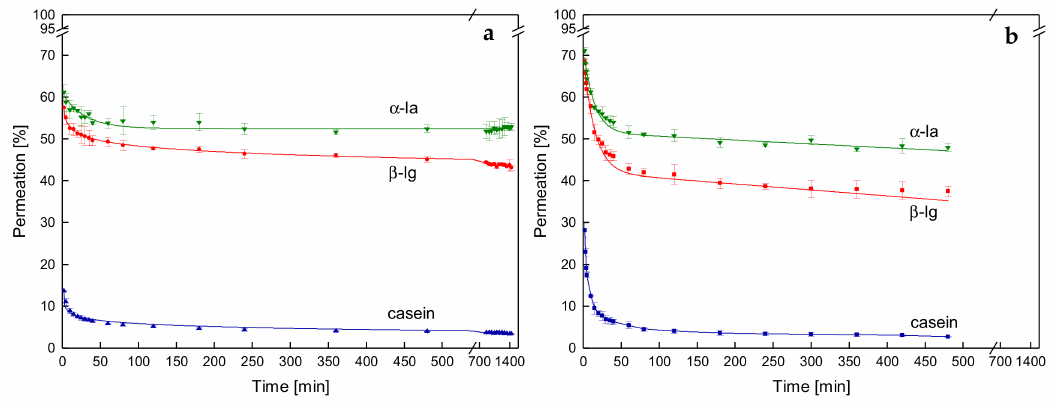
Figure 6. Permeation of di ff erent-sized proteins as a function of time at the ∆ p TM of 0.5 bar and 10 ◦ C ( a ) or 50 ◦ C ( b